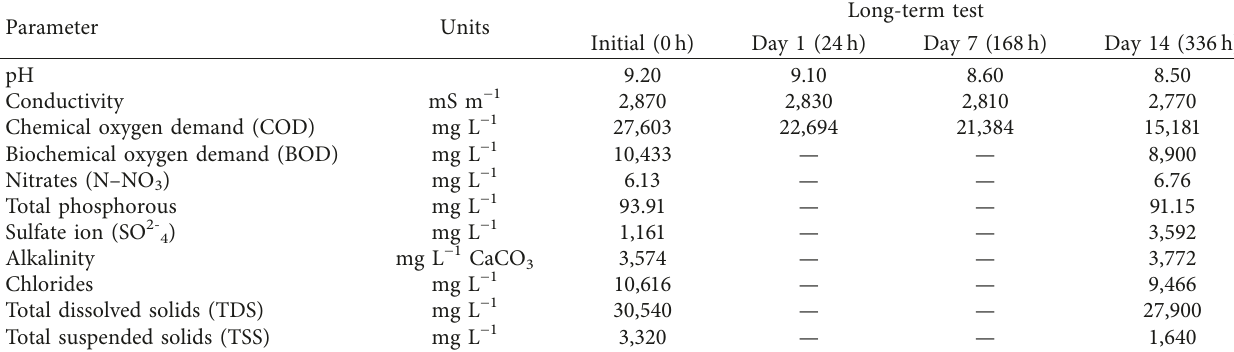
Table 3: Physicochemical parameters of PWW at different times during the long-term test. No determined.